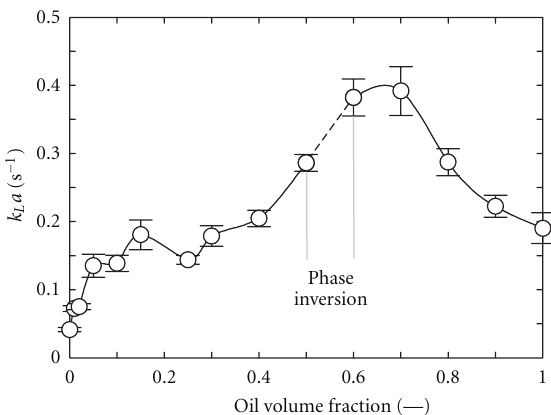
Figure 7: E ff ect of n-heptane volume fraction on k L a .